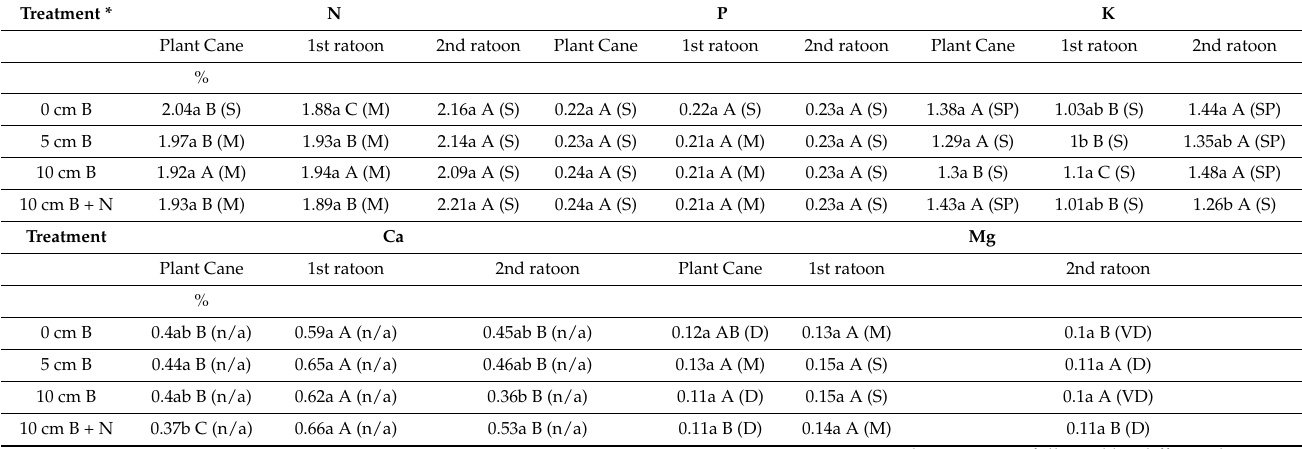
Table 4. Leaf macronutrient concentrations for plant cane and two ratoon